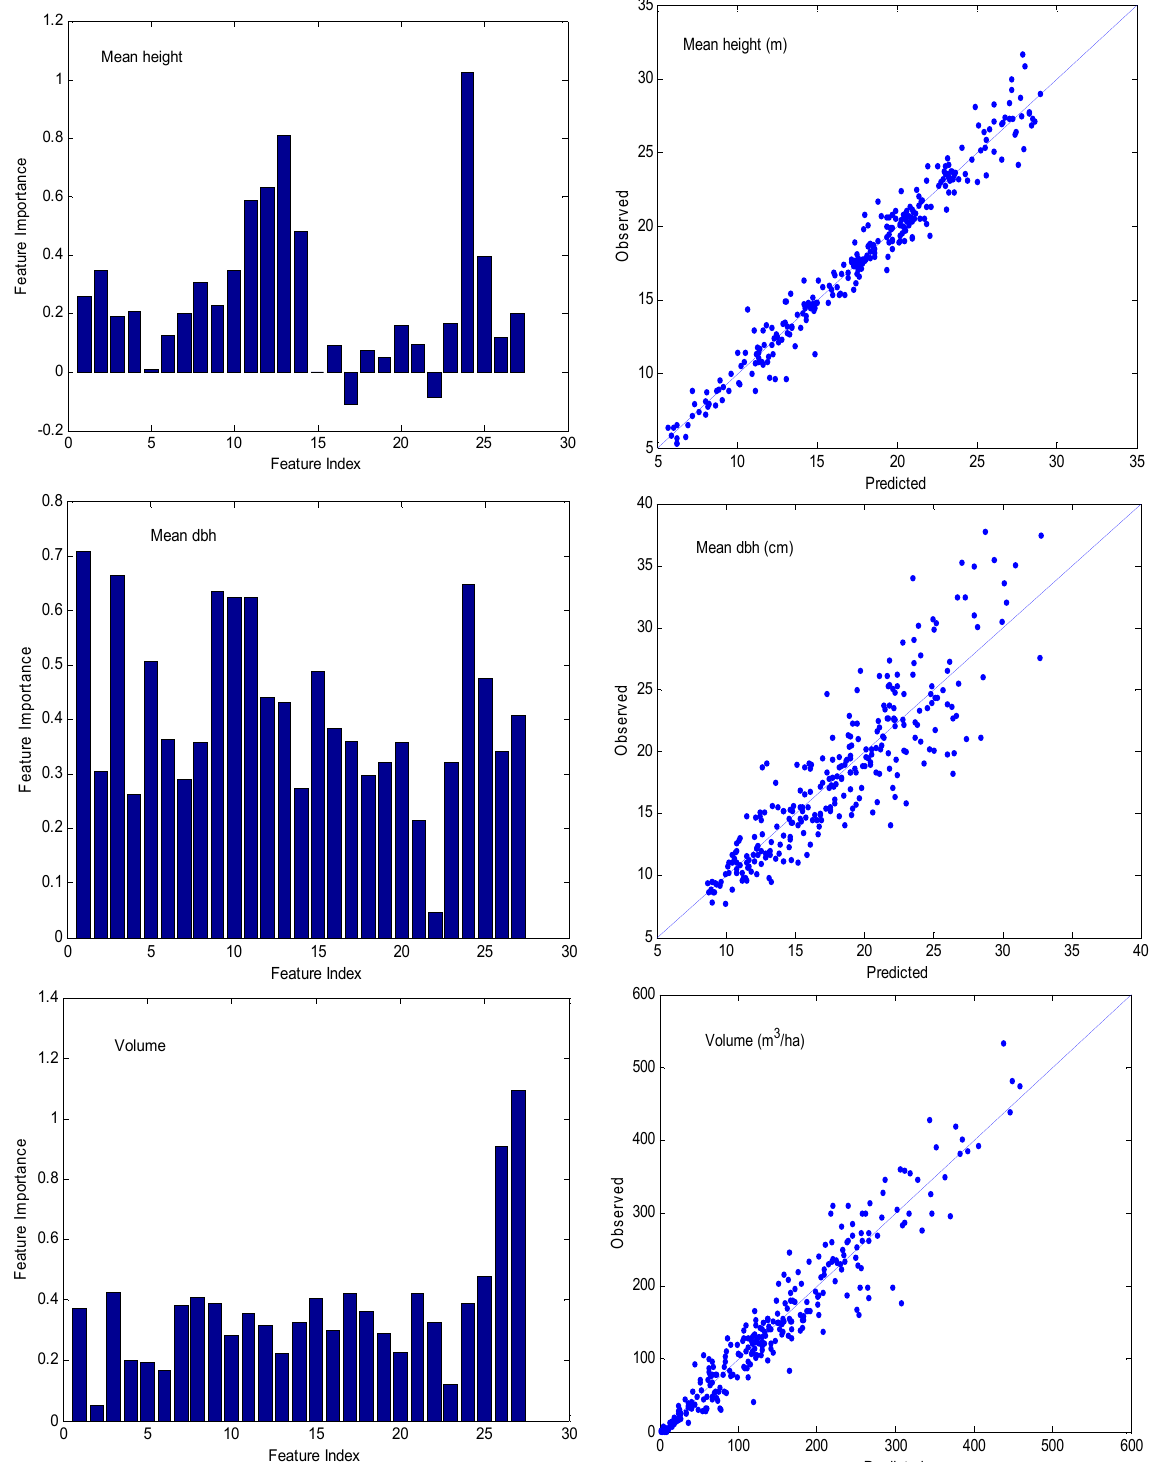
Figure 6. The feature importance (in the left column) and a scatter plot of the predicted versus observed values (in the right column) for mean height, mean DBH and volume estimates based on all features. The order of the feature index is the same as in Table 2 (24–27 are the individual tree-based